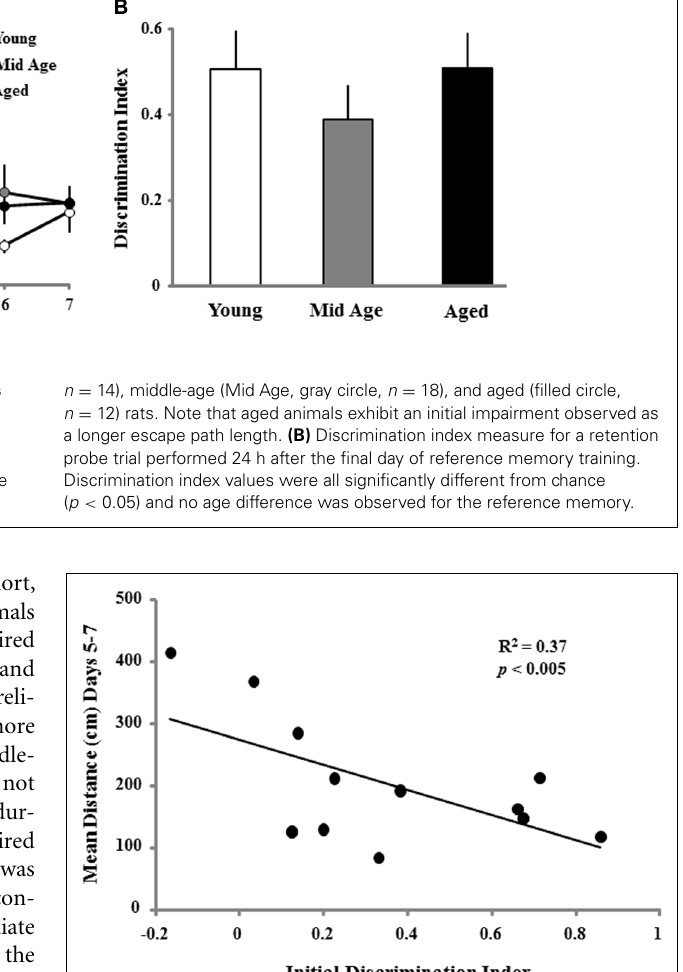
FIGURE 10 |Acquisition discrimination index scores for the initial day of spatial training is related to acquisition of a spatial reference memory in aged animals. For aged rats ( n = 12), a significant correlation was observed for the initial acquisition discrimination index scores and the mean escape distance for days 5–7 on the reference memory